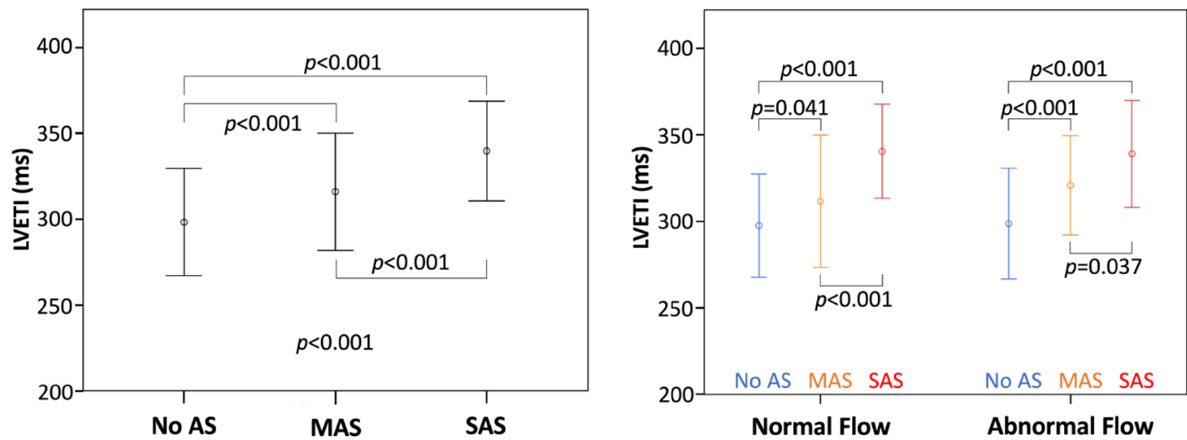
Figure 5. Mean left ventricular ejection time index (LVETI) according to aortic stenosis (AS) grading ( left ) and to flow status and AS grading ( right ). Abnormal flow is identified by stroke volume index ≤ 35 mL/m 2 or flow rate ≤ 210 mL/s. MAS, moderate AS; SAS, severe